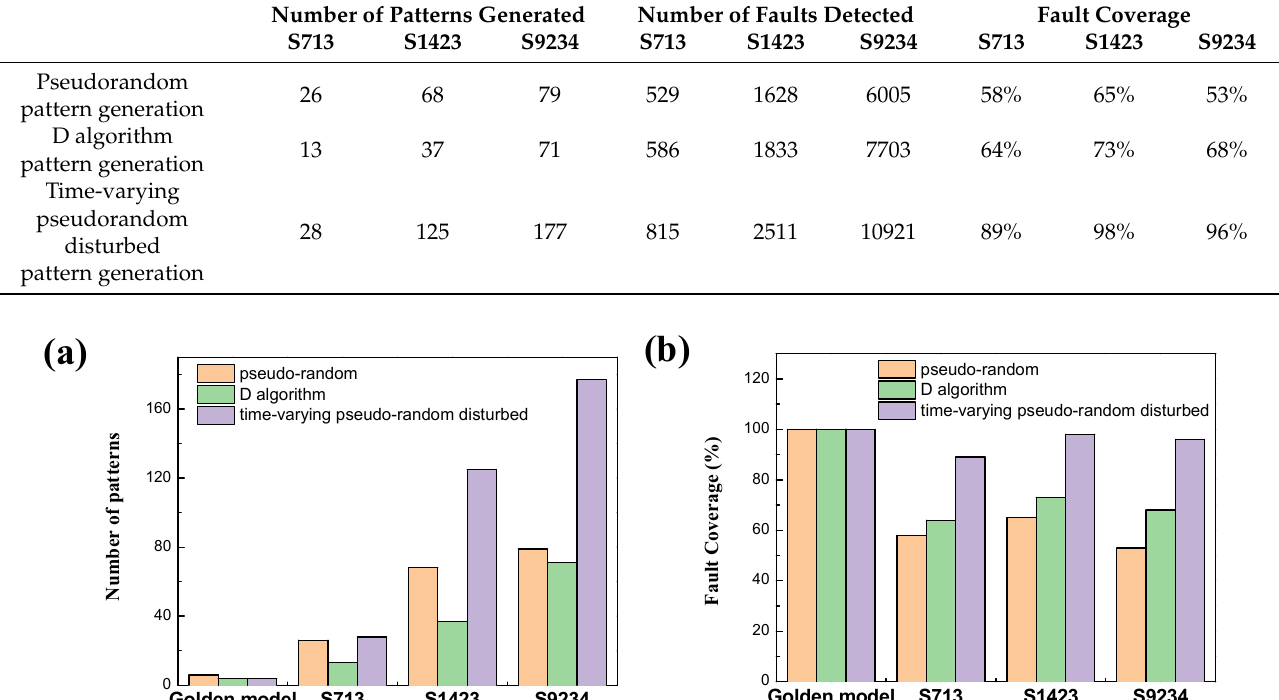
Table 1. Generated results of each algorithm.